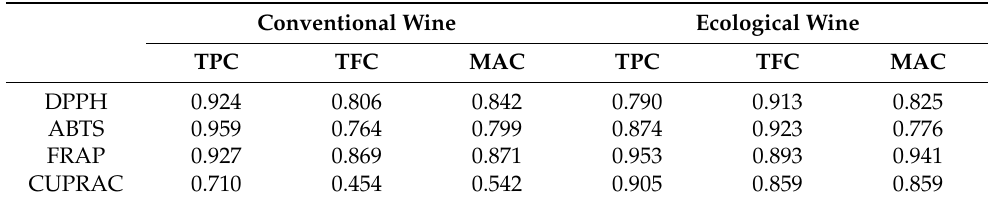
Table 9. Correlation coefficients ( r ) between TPC, TFC, MAC, and antioxidant activities obtained by DPPH, ABTS, FRAP, and CUPRAC methods in conventional and ecological Cabernet Sauvignon wines and their RO retentates at 2.5, 3.5, 4.5, and 5.5 MPa, with cooling and without cooling. Conventional Wine Ecological Wine TPC TFC MAC TPC TFC MAC DPPH 0.924 0.806 0.842 0.790 0.913 0.825 ABTS 0.959 CUPRAC 0.710 0.454 0.542 0.905 0.859